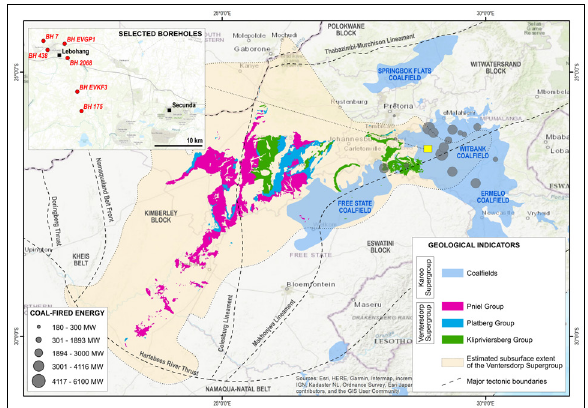
Figure 2: Overview of the extent of the Ventersdorp Supergroup. Included are the positions of the major point-source CO their associated coalfields. Inset shows locations of geological boreholes used in this study. Data from the Council for Geoscience Data Portal. 28